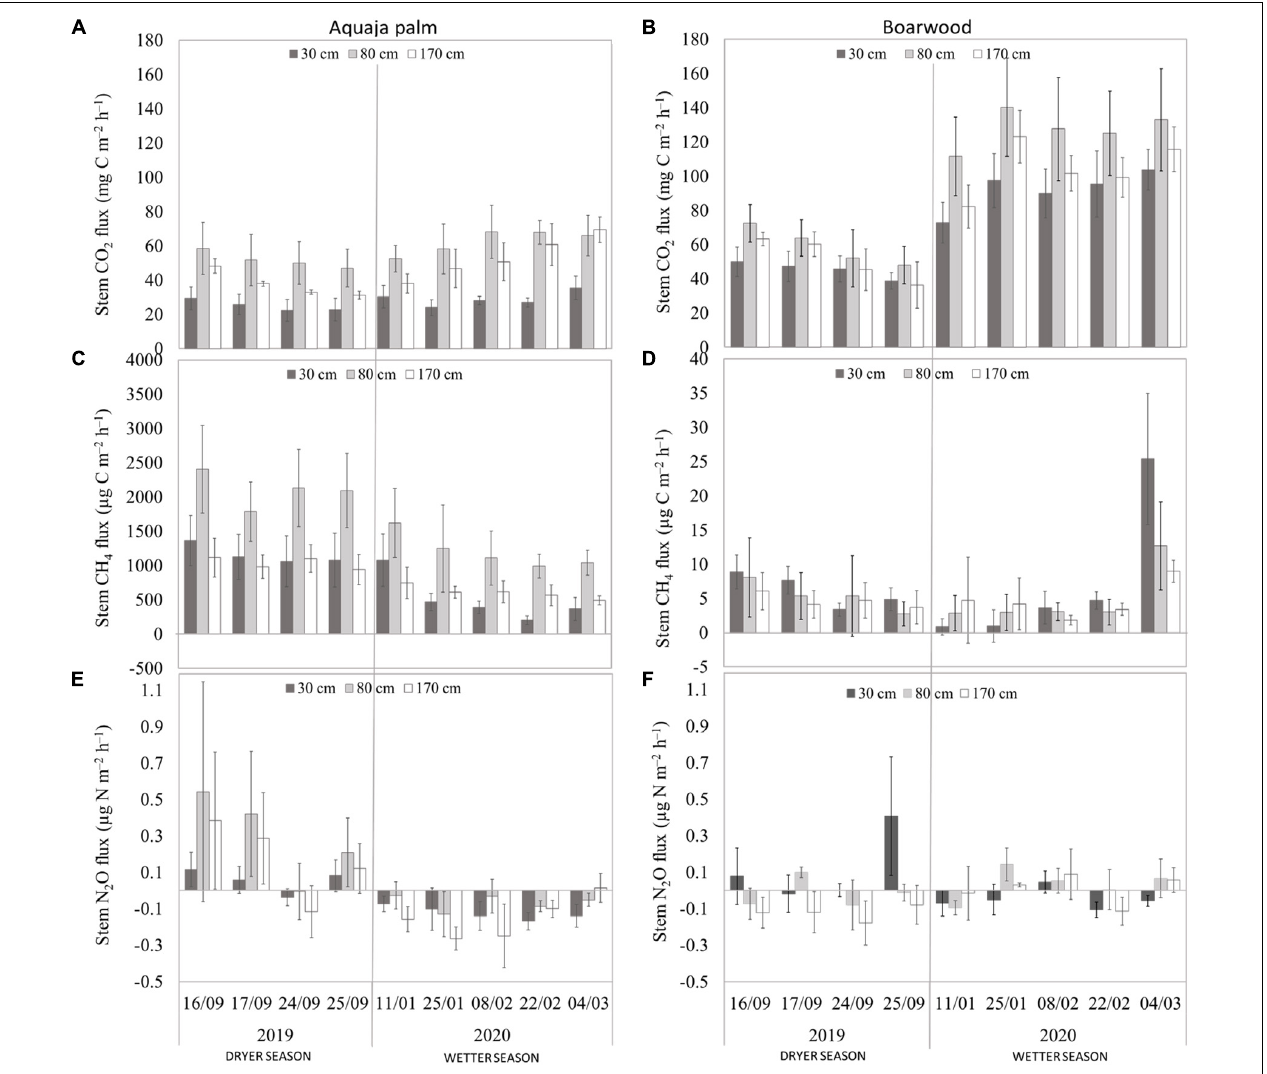
FIGURE 1 | Temporal variation of stem CO 2 (A,B) , CH 4 (C,D) , and N 2 O (E,F) fluxes (session average ± SE) from different heights of aguaje palm (A,C,E) and boarwood (B,D,F) stems. Note that y-axis for stem CH 4 (C,D) fluxes have different